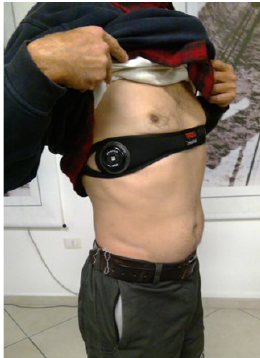
Figure 4. Zephyr Bioharness device worn by a worker.